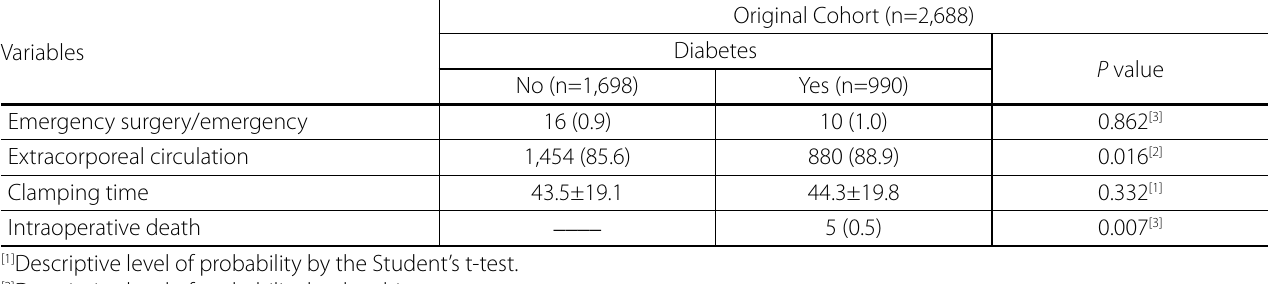
Table 3. Descriptive values [average ± standard deviation or n (%)] of surgical variables according to the study group. Variables